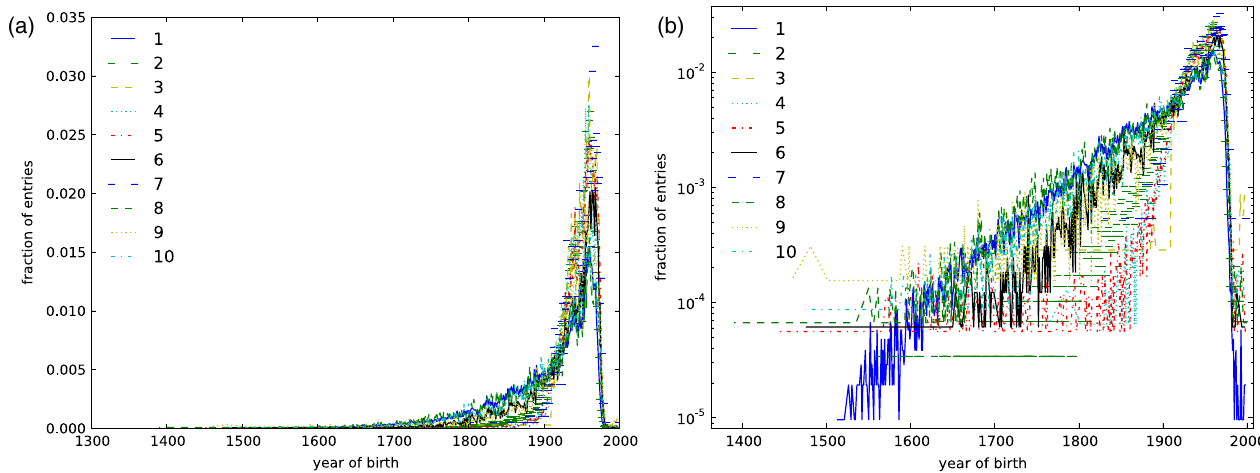
FIG. 9. Fraction of entries in each jokbo as a function of the birth year of brides using (a) linear and (b) semilogarithmic scales. The sudden drop on the right of each panel simply reflects the fact that women who are too young are not yet married.